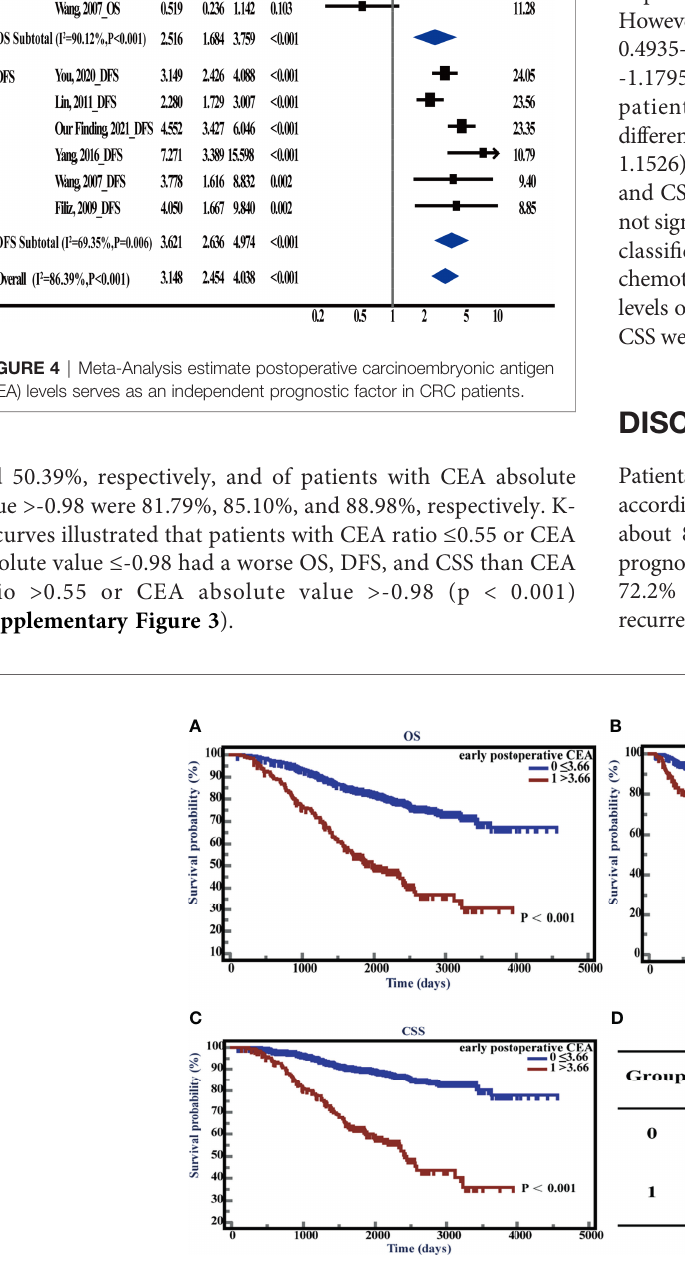
FIGURE 5 | Overall survival (OS), disease-free survival time (DFS), and cancer-speci fi c survival (CSS) with respect to postoperative carcinoembryonic antigen (CEA) levels. (A) K-M curves of OS based on postoperative CEA levels. (B) K-M curves of DFS based on postoperative CEA levels. (C) K-M curves of CSS based on postoperative CEA levels. (D) 5-year OS, DFS, and CSS of normal and elevated